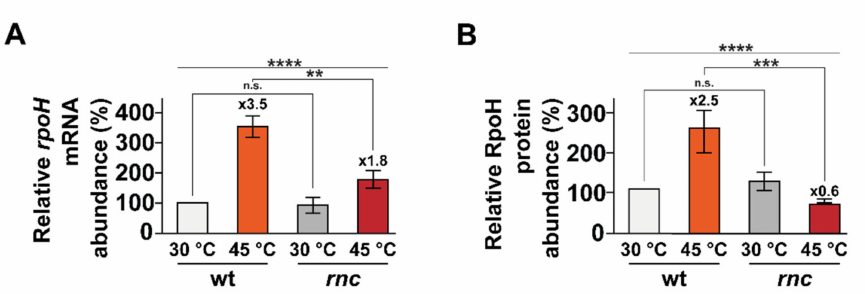
Figure 3. rpoH induction upon temperature upshift is defective in the rnc mutant. Strains wt and rnc were grown at 30 ◦ C and transferred to 45 ◦ C. Total RNA and protein sampled before or after a heat shock were analyzed by northern blot (see Figure S2) and Western blot (see Figure S3). ( A ) Mean rpoH mRNA levels and ( B ) mean RpoH protein levels are indicated before (30 ◦ C, in grey) and after ( A ) 15 min or ( B ) 5 min of heat shock (45 ◦ C, in red). Values are means of 3 biological replicates and error bars are standard deviations. Statistical significance was determined by ANOVA (n.s. for p -values ≥ 0.05, ** for p -values ≤ 0.01, *** for p -values ≤ 0.001 and **** for p -values ≤